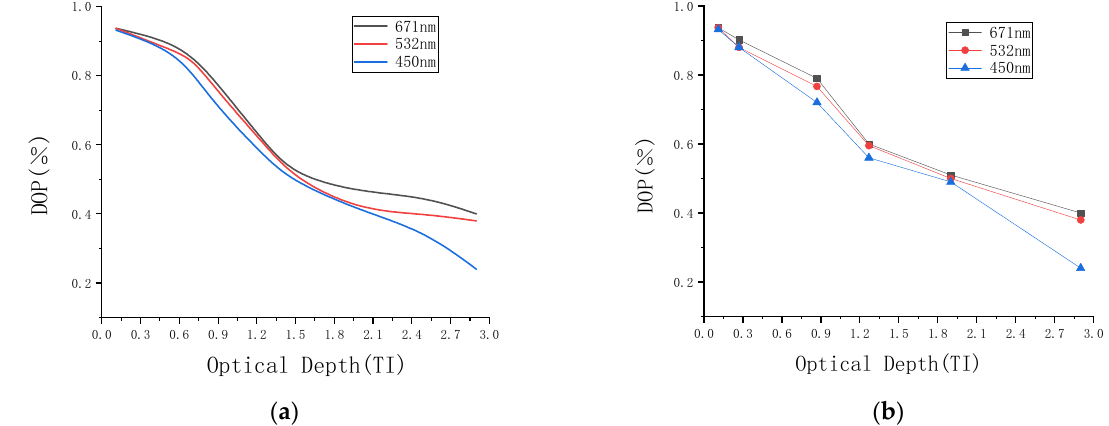
Figure 11. Simulation and experimental comparison of DOP changes in three bands when the incident light is 0-degree linearly polarized light: ( a ) simulation results and ( b ) experimental results.